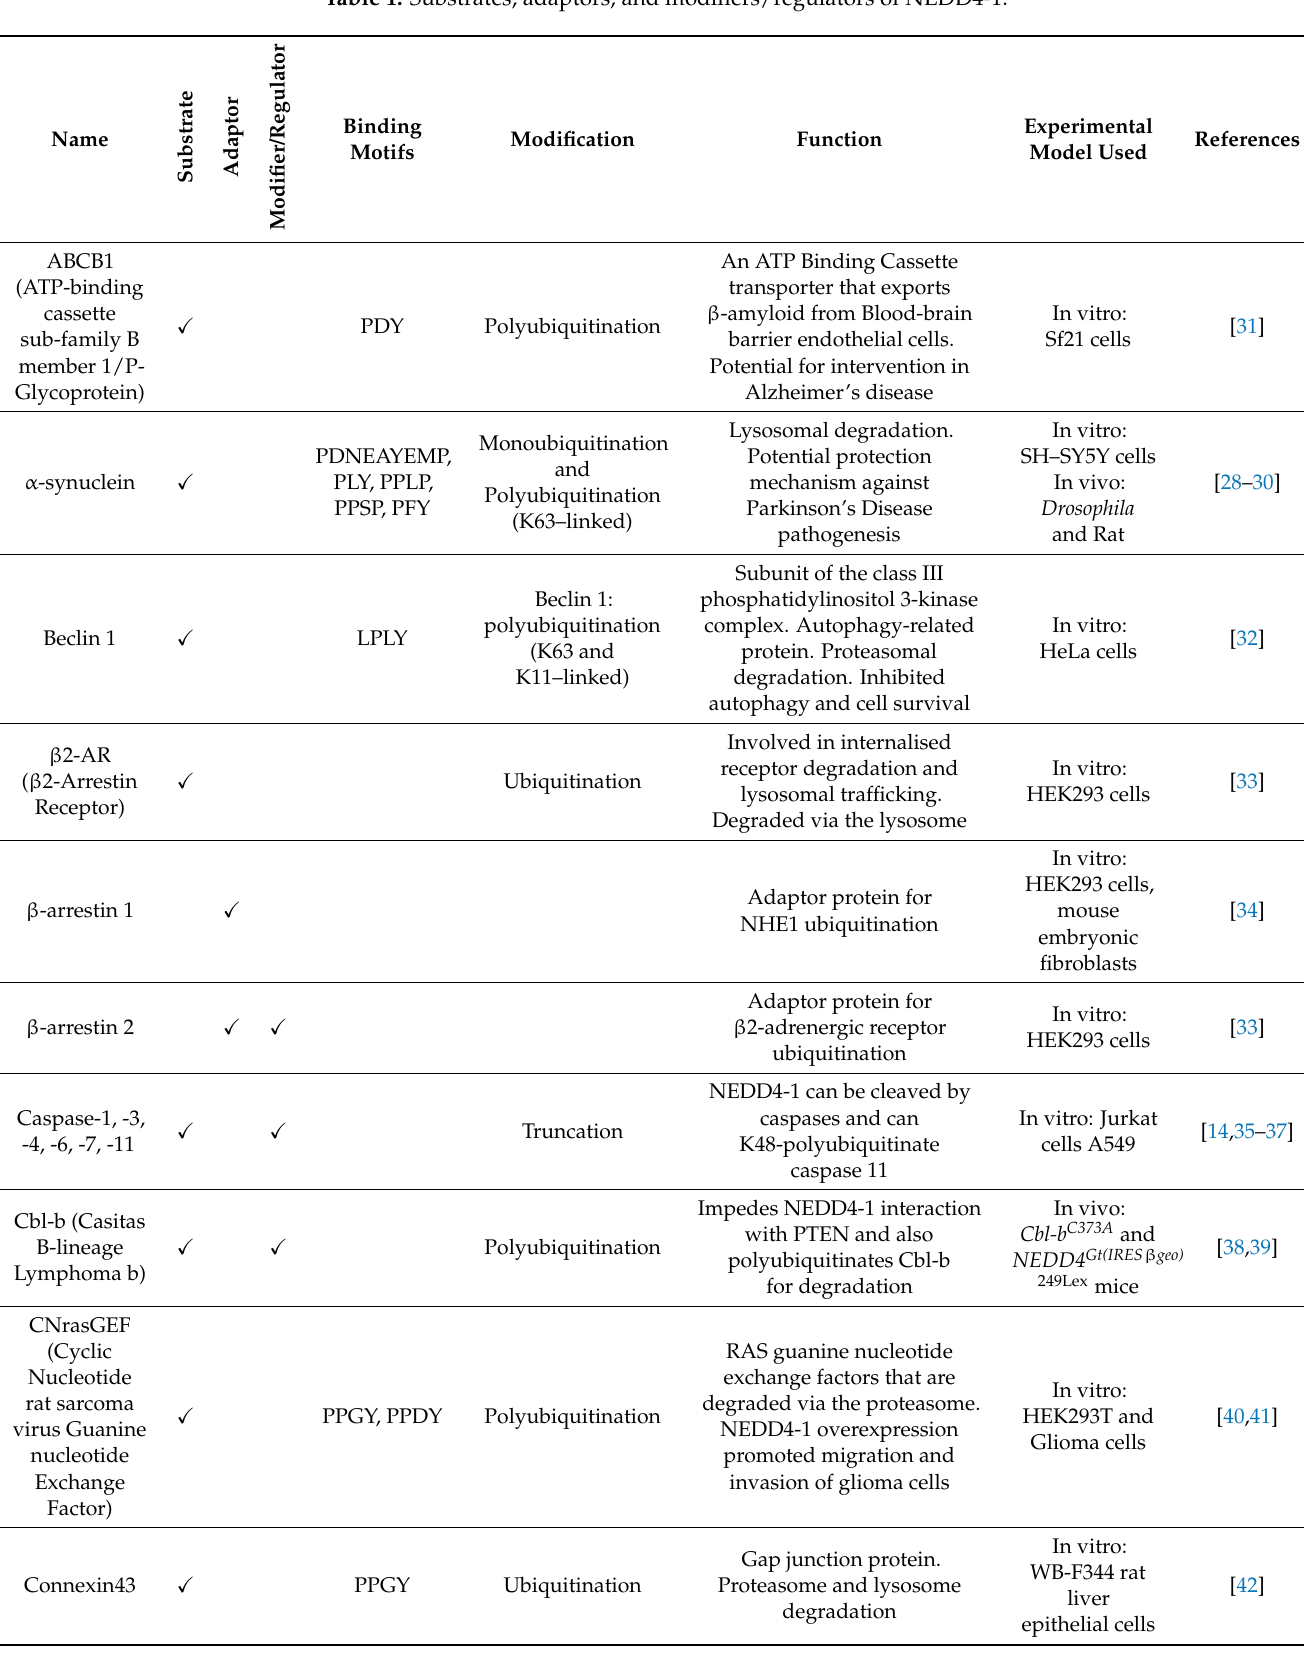
Table 1. Substrates, adaptors, and modifiers/regulators of